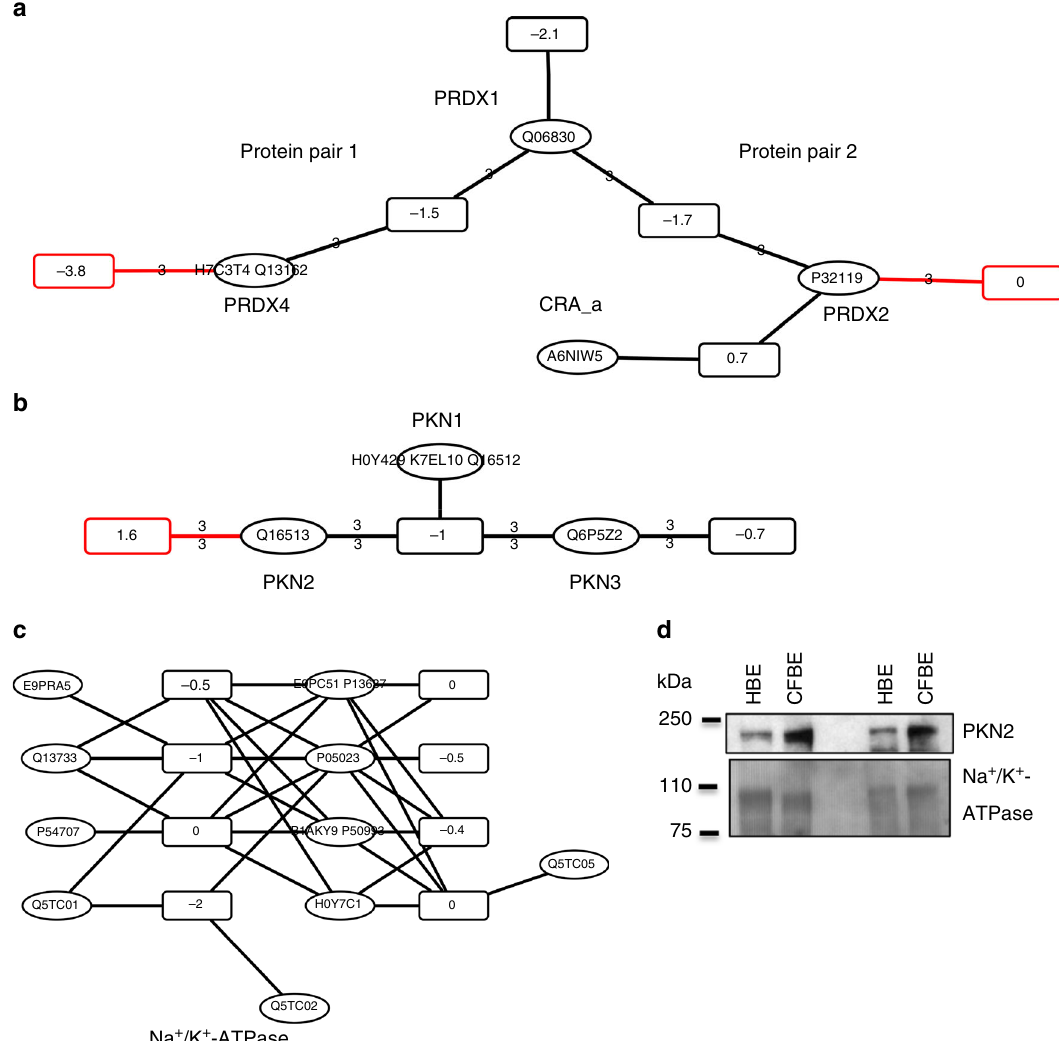
Fig. 7 Select peptide-to-protein clusters with proteins differentially regulated in CFBE41o – vs. HBE41o – cells. a The protein cluster shows the family of related peroxiredoxin (PRDX) proteins. Edges and peptide node outlines in red as well as number associated with the edge in the peptide-to-protein clusters indicate differential expression according to the protein pair-centric analysis. b The protein cluster of serine – threonine kinase-related protein kinases PKN1, PKN2, and PKN3 is displayed. c The peptide-to-protein cluster of Na/K-ATPase proteins is depicted. It is expressed at the same levels in HBE41o – and CFBE41o – cells. d Western blot analysis was used to verify the difference in PKN2 expression levels between HBE41o – and CFBE41o – cells. Na + /K + -ATPase expression levels are shown as a loading control. Data in the western blot represent independent biological replicates, CFBE41o – : n = 2, HBE41o – : n =